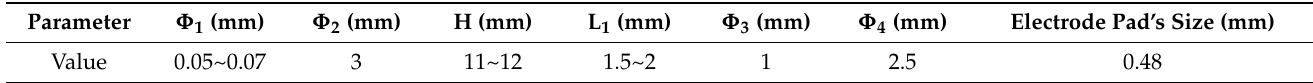
Figure 1. Coreless motor’s winding and its assembly process: ( a ) The winding of coreless motor; ( b ) Electrode wires are dragged and placed on the pads through automated wire bonding technique; ( c ) Electrode wires are soldered through automated wire bonding technique; ( d ) Final coreless motor is assembled through automated winding assembly technique. Table 1. Geometric dimensions of coreless motor’s